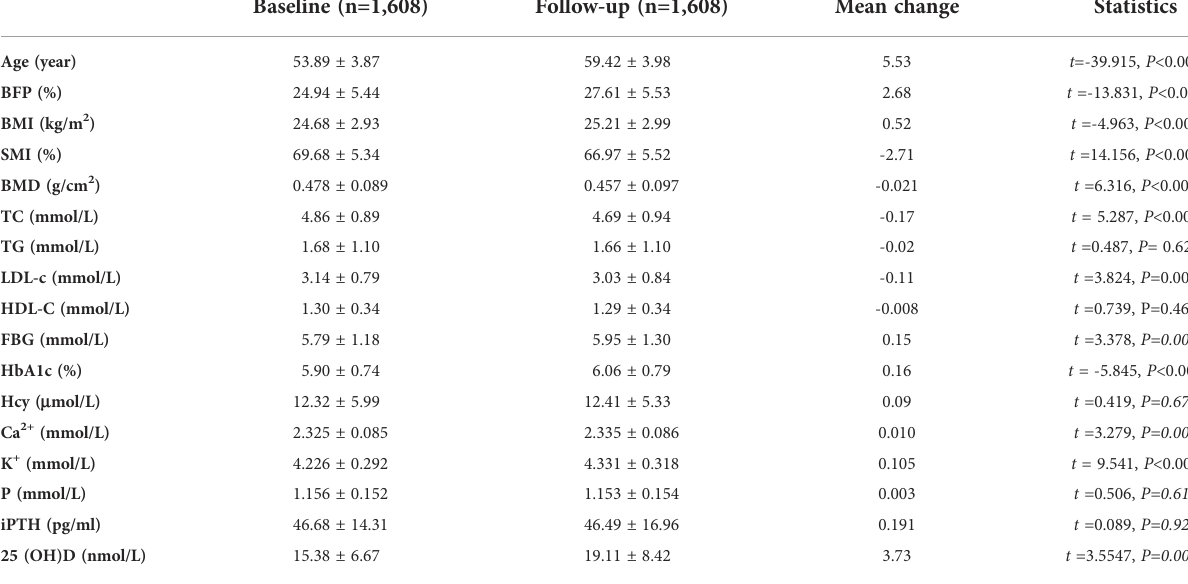
TABLE 3 Comparison of clinical data before and after completion of follow-up (n=1,608).